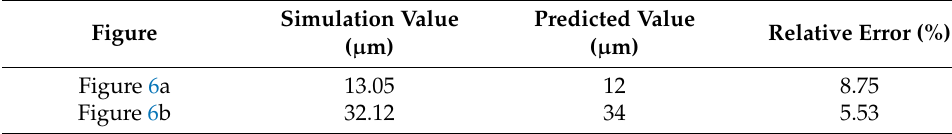
Table 3. Average grain size error of some